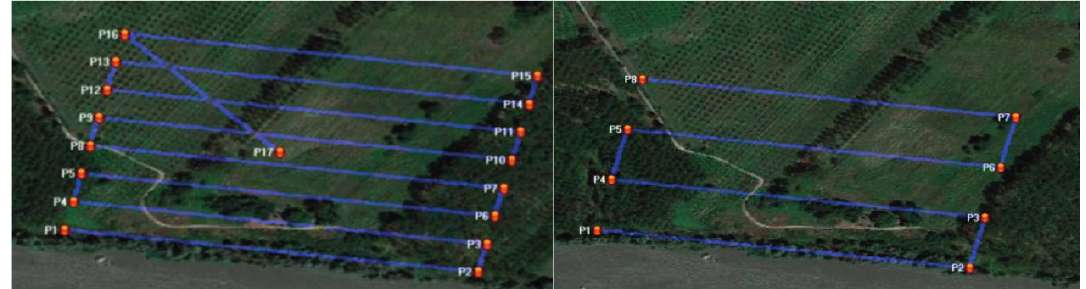
Figure 4. The multi-rotor RPAS planned flight plans: 70-m flight height above the ground ( left ) and 150-m flight height above the ground flight ( right ).